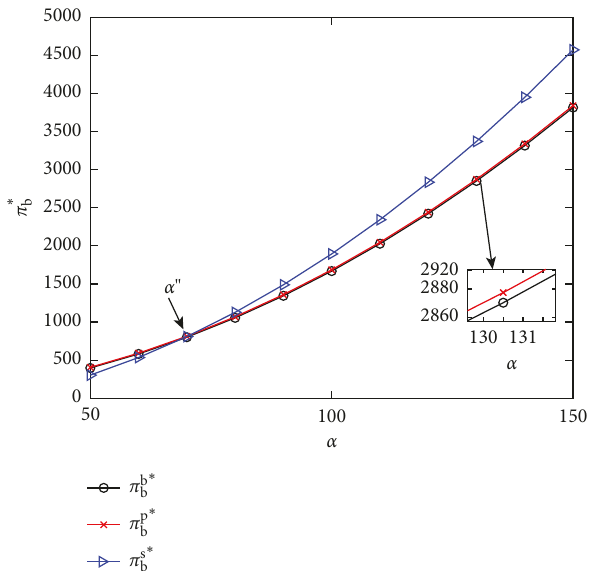
Figure 10: Impact of change in α on the business’s optimal profit.